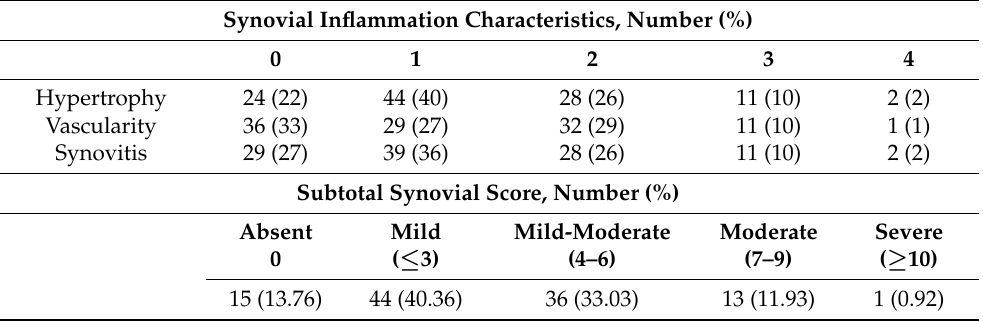
Table 4. Synovial inflammation characteristics (0–4) and subtotal synovial score in the suprapatellar pouch (0–12) (N =